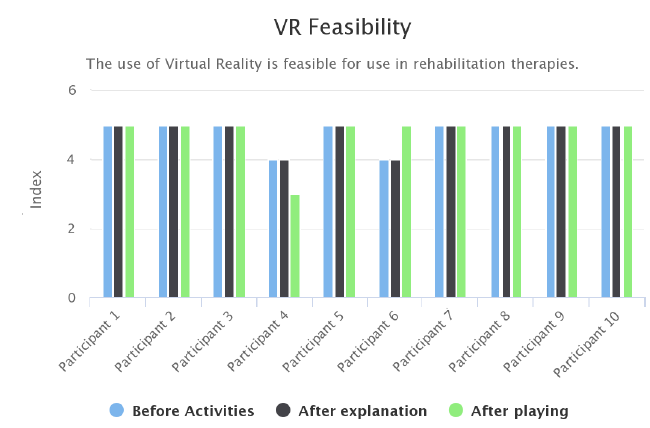
Figure 8: Physiotherapists opinion about the feasibility of using VR during therapy processes before and after the experiment